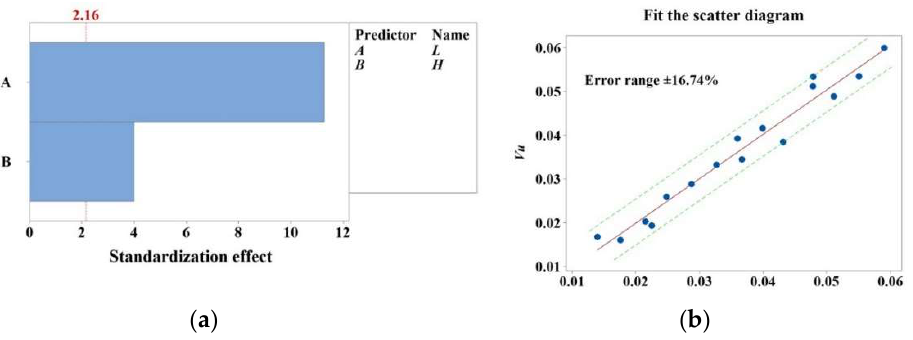
Figure 6. ( a ) Pareto chart for two factors at α = 0.05; ( b ) Scatter plot.